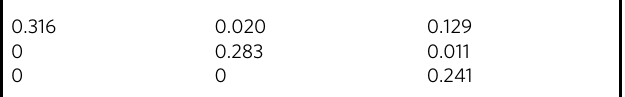
Table 2 Normalised assortativity matrix.